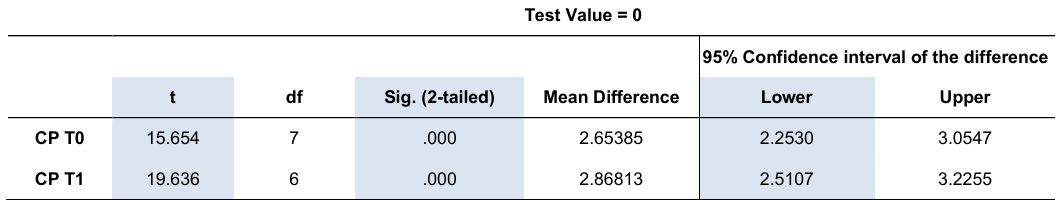
Table 6d: One-sample test a − male